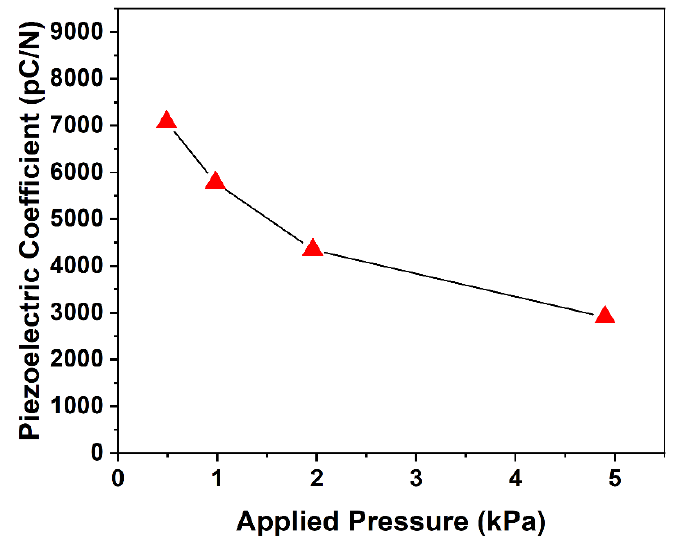
Figure 4. Quasi-static piezoelectric coefficient of the printing COC piezoelectret (L = 15 mm, h = 1 mm); charging voltage was 5 kV.